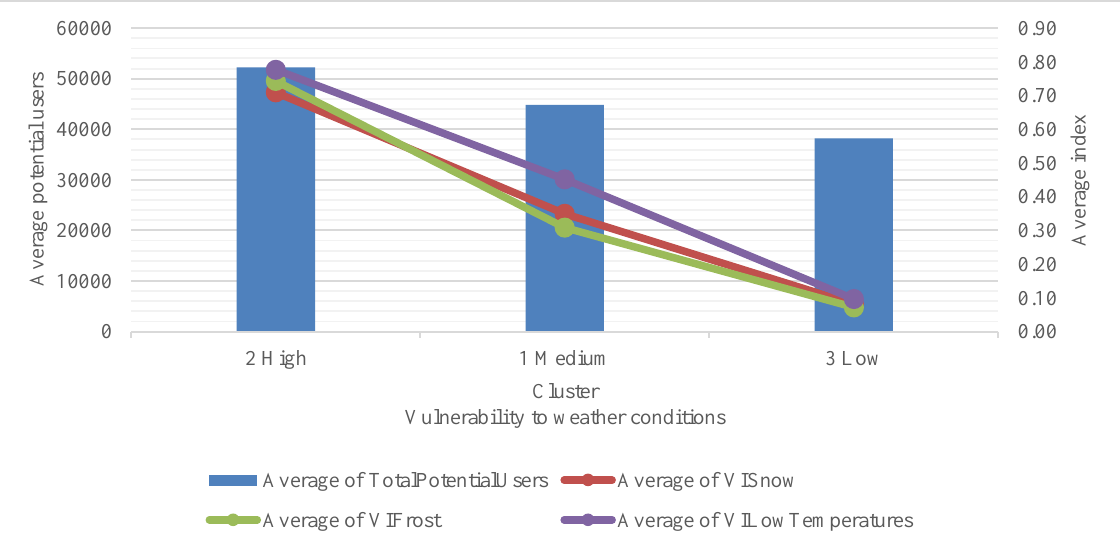
Figure 13 Average potential users by clusters of vulnerability to winter weather